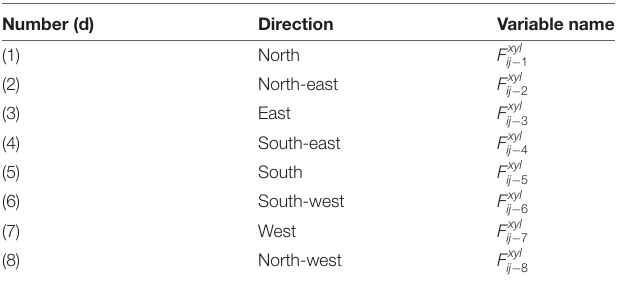
TABLE 1 | Xylem flux directions